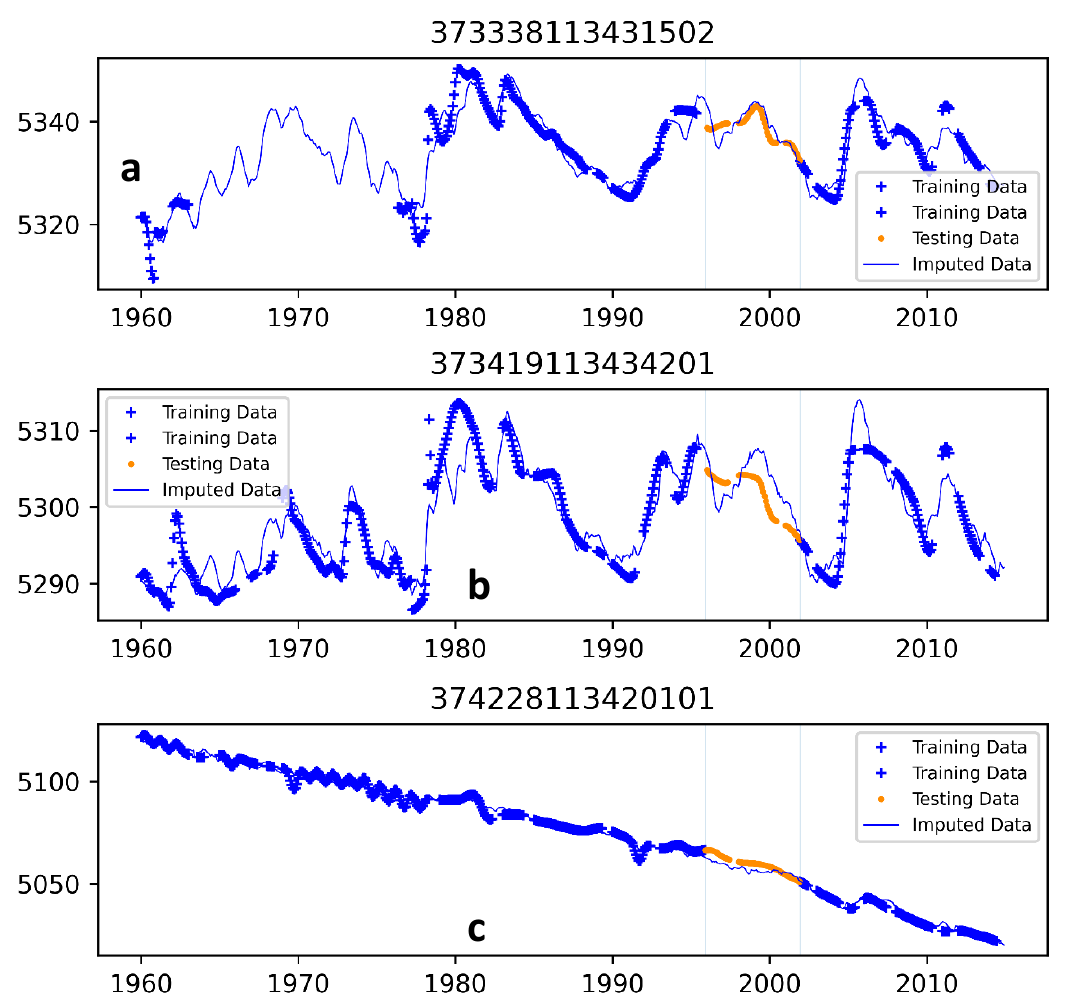
Figure 9. ELM results over a 7-year testing period from 1997–2002 for Wells 373338113431502, 373419113434201, and 373527113415101, as subfigures ( a – c ), respectively. Imputed data are solid blue lines, measured data used for training are blue crosses, and measured data used for testing are orange dots.